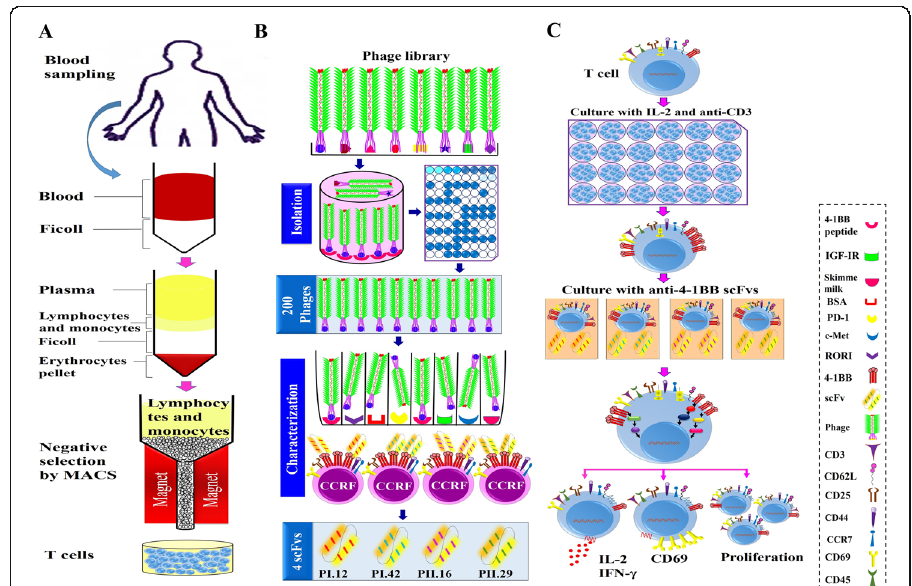
Fig. 1 Schematics describing the isolation of human T cells, selection of anti-4-1BB single chain fragment variable antibodies (scFvs), and T-cell treatment. a Isolation of CD3 + T cells from peripheral blood via ficoll and negative selection (depletion of unwanted cells) using magnetic affinity cell sorting (MACS). b Isolation and characterization of four anti-4-1BB scFvs (PI.12, PI.42, PII.16 and PII.29) via phage display technology. c Stimulation of T cells with IL-2 and anti-CD3, treatment with anti-4-1BB scFvs and analysis of the effects of scFvs on T